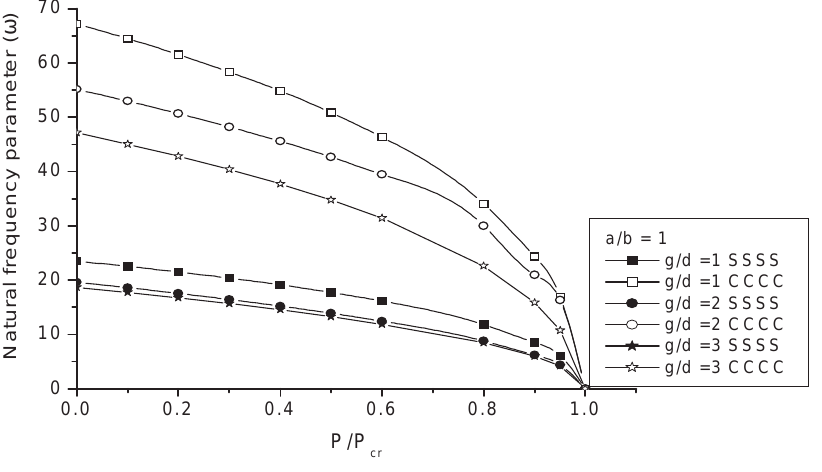
Fig. 17. Effect of aspect ratios of cutout cross-section ( g/d = 1, 1.5, 2, 3) on vibration frequency for stiffened square plates with cutouts having one central longitudinal stiffener ( δ = 0.1 and γ =